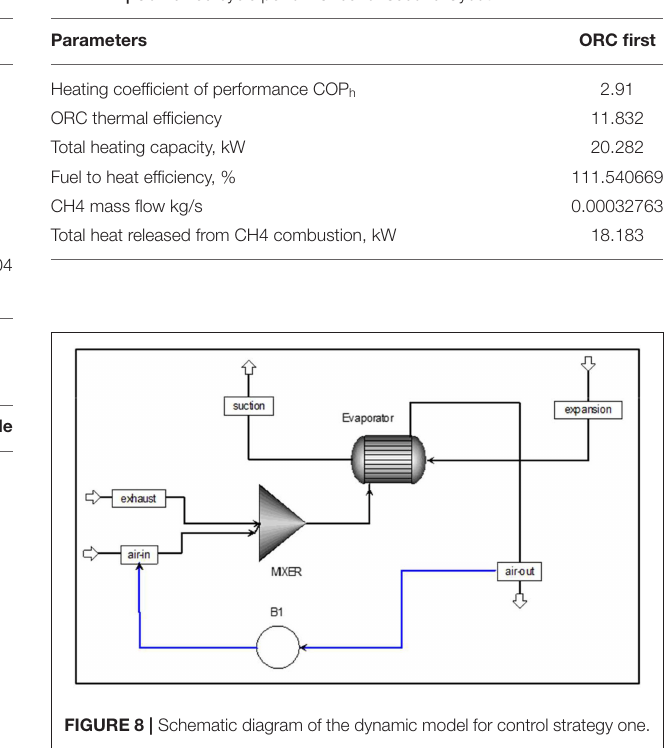
TABLE 4 | Combined cycle performance for second layout.